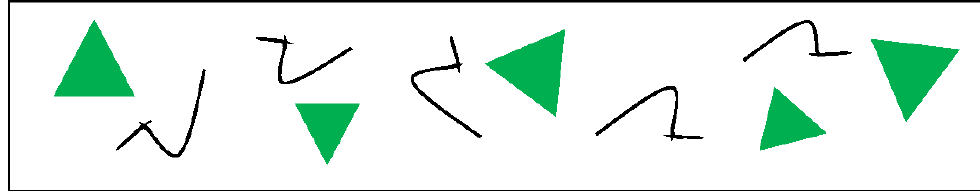
Figure 5. Mixed pattern built of p = 5 irregular non-symmetric curves and p = 5 equilateral triangles. The symmetry group of the equilateral triangle is the dihedral symmetry group D 3 containing 3 p symmetry axes and 3 p rotations (including the 2 π rotation, denoted G 1 ). One more G 1 operation comes from the irregular curves; thus, we have in total 7 p symmetry operations in this pattern. The IMS is easily calculated according to Equation (2): H sym = − details, see